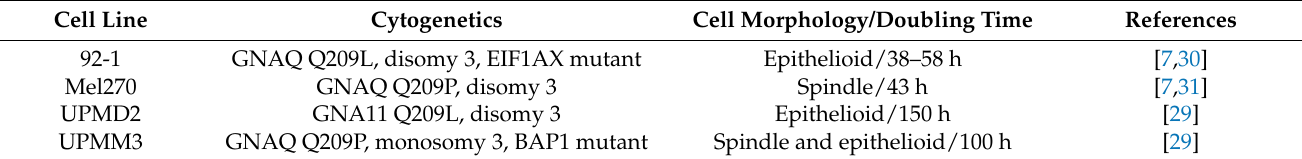
Table 1. Characteristics of uveal melanoma cell